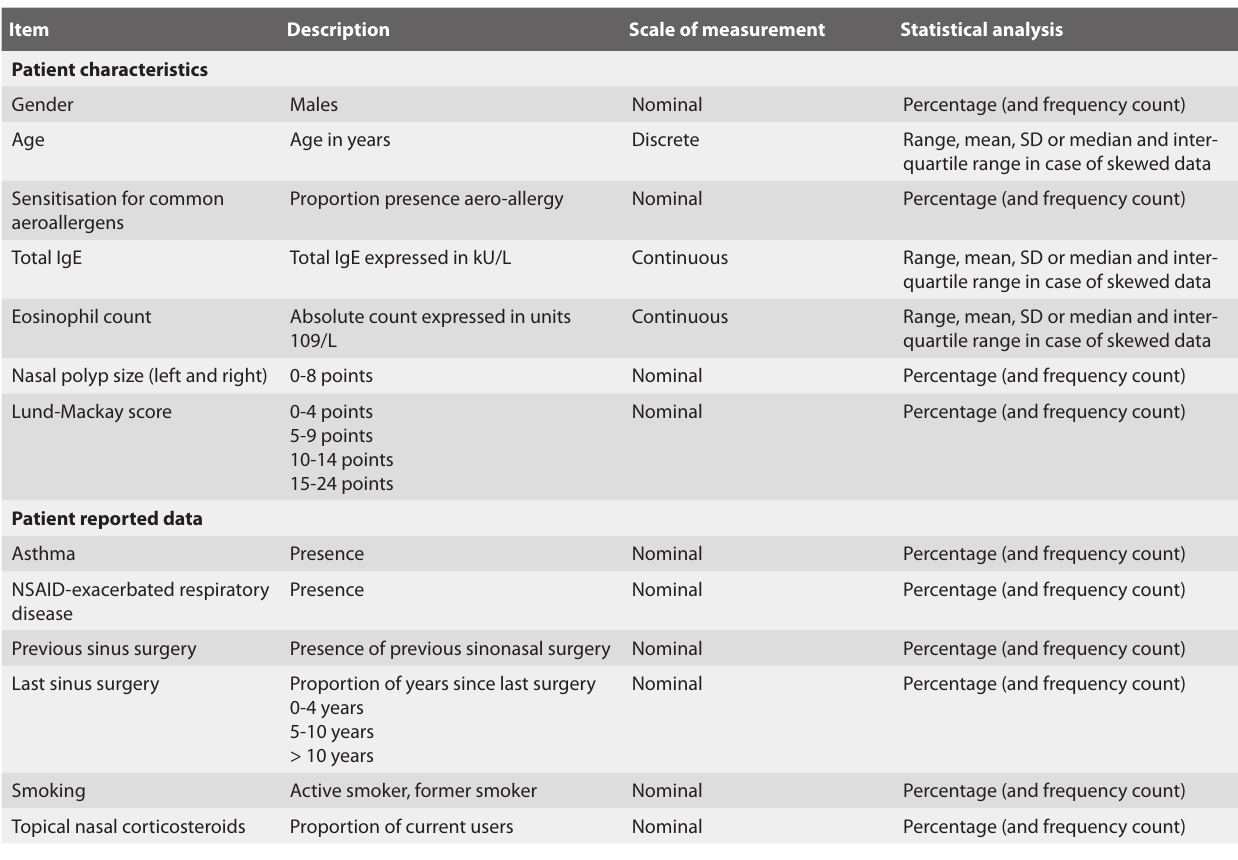
Table 1. Baseline characteristics (data will be reported for both groups, total